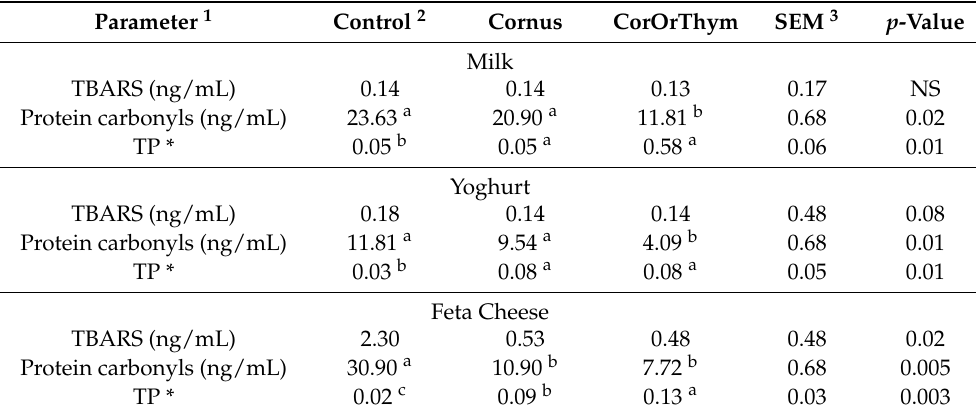
Table 10. Effects of diet supplementation with cornus extract and oregano and thyme essential oils on antioxidant status of milk, yoghurt and Feta cheese.